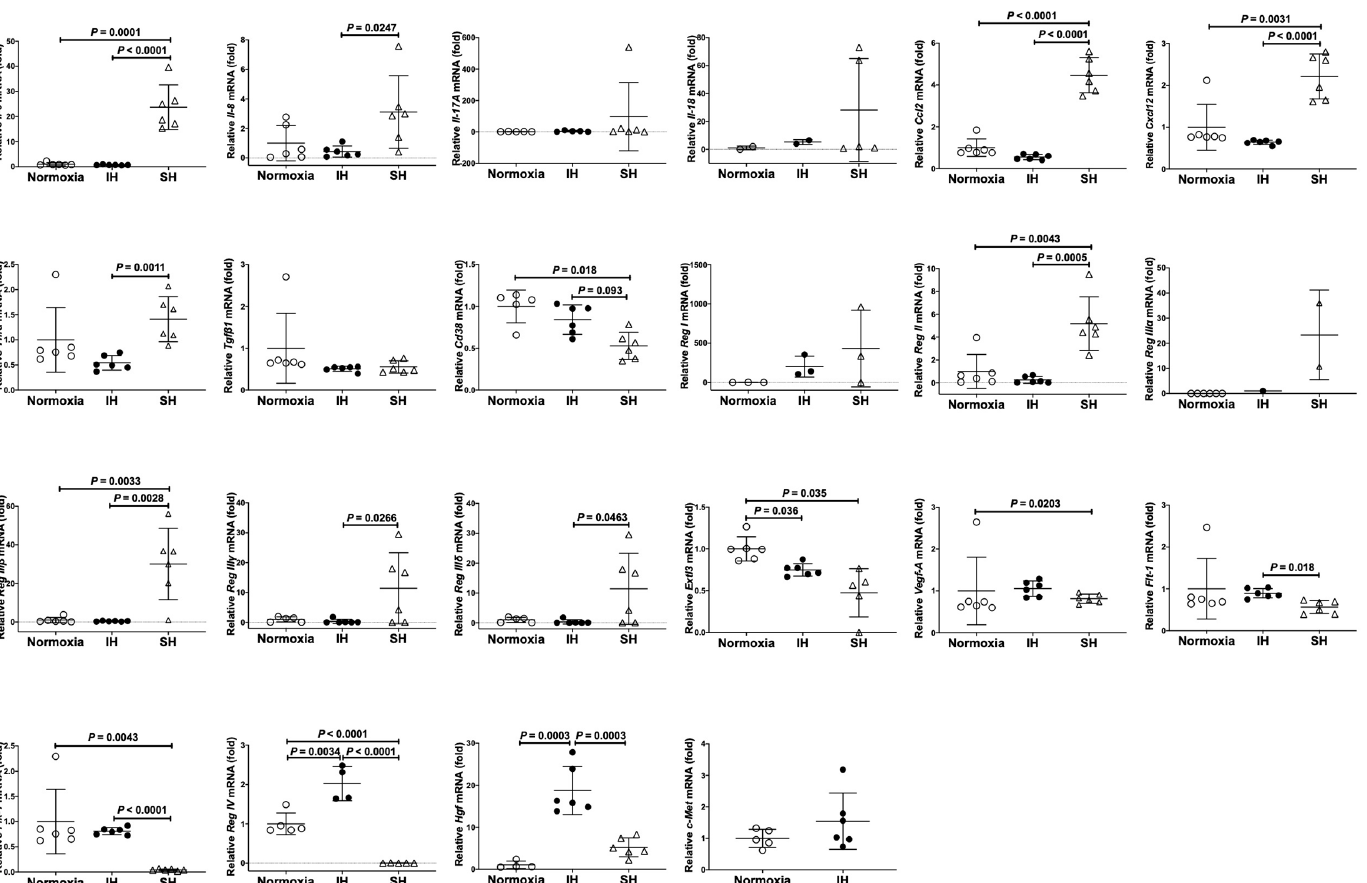
Figure 2. The mRNA levels of mouse Il-6 , Il-8 , Il-17A , Il-18 , Tgf β 1 , Ccl2 , Cxcl12 , Tnf α , Vegf-A , Flt-1 , Flk-1 , Cd38 , Reg I , Reg II , Reg III α , Reg III β , Reg III γ , Reg III δ , Reg IV , Extl3 , Hgf , and c-Met in mouse P19.CL6 cardiomyocytes. Mouse P19.CL6 cells were treated with normoxia, IH, or SH for 24 h. The mRNA levels were measured by real-time RT-PCR and normalized by Rig/RpS15 as an internal standard. The mRNA levels exposed to normoxia were set to 1.0. Open and closed circled circles indicate values of relative mRNA expression of cells exposed to normoxia and IH, respectively. Data are expressed as the mean ± SD of the samples. Statistical analyses were performed using Student’s t -test. IH significantly increased the mRNA levels of Reg IV and Hgf in mouse P19.CL6 cells. SH significantly increased the mRNA levels of Il-6 , Il-8 , Ccl2 , Cxcl12 , Tnf α , Reg II , Reg III β , Reg III γ , and Reg III δ in P19.CL6 cells. IH and/or SH decreased mRNA levels of Cd38 , Extl3 , Vegf-A , Flt-1 , and Flk-1 . The other gene expressions ( Il-17A , Il-18 , Tgf β 1 , Reg I , Reg III α , and c-Met ) did not show significant changes.